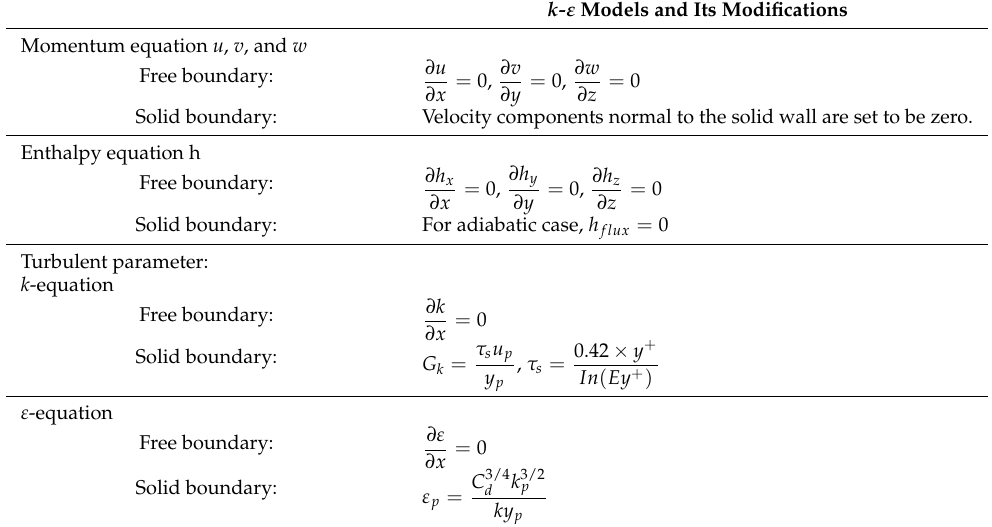
k- ε Models and Its